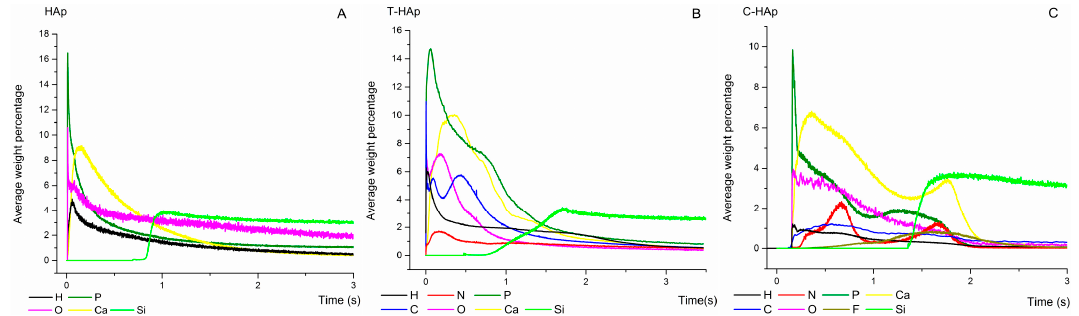
Figure 9. Depth profile curves of HAp ( A ); T-HAp ( B ) and C-HAp ( C ) thin films.